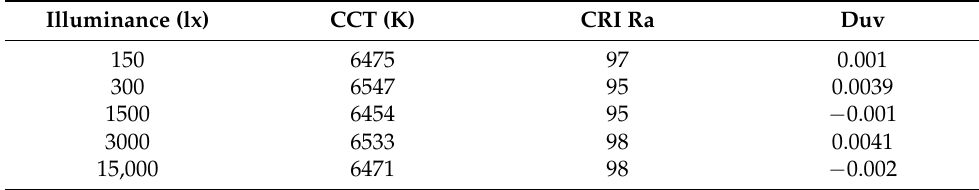
Table 3. Colorimetric characteristics of the five light